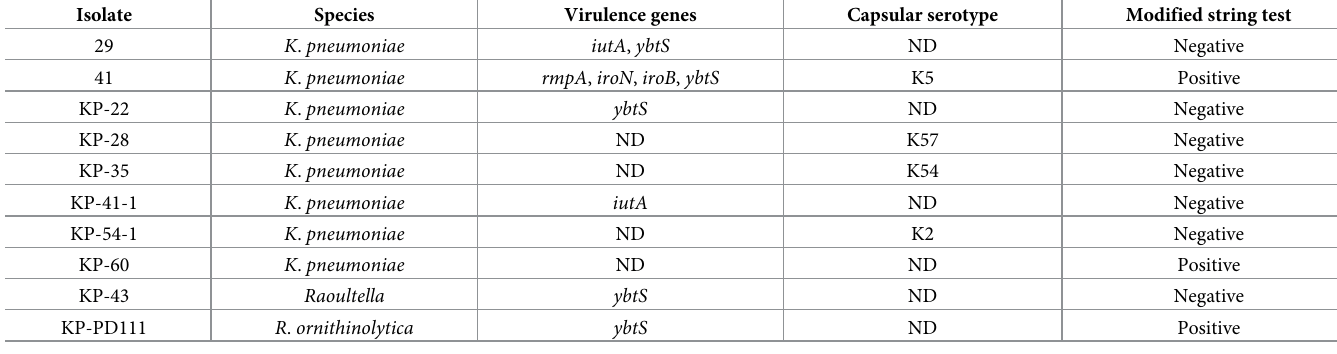
Table 6. The results of hypermucoviscosity phenotype and virulence-related genes.